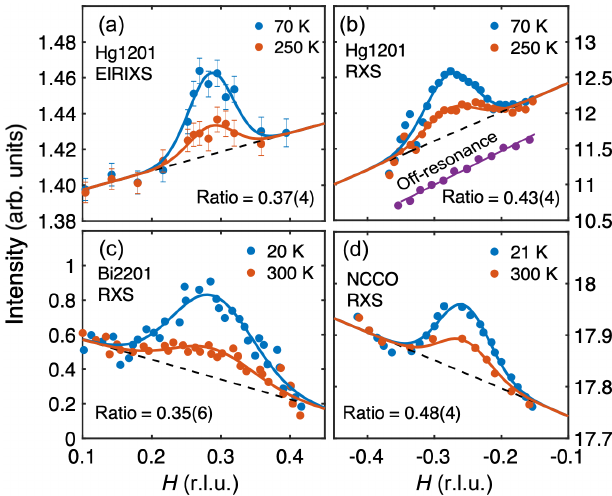
FIG. 5. (a) Energy-integrated RIXS (EIRIXS) data for Hg1201, integrated over the entire experimental energy range ð − 10 ; 2 Þ eV, both at T and 250 K. (b) Prior RXS data for Hg1201 at the same c doping level and temperatures as in (a), along with 70 K data taken off resonance with an incident photon energy of 929 eV, reproduced from Ref. [9]. (c) RXS measurement of Bi 2 Sr 2 − La CuO 6 þ δ (Bi2201, x ¼ 0 . 115 ) at ∼ T and 300 K, x x c reproduced from Ref. [8]. (d) RXS results for superconducting electron-doped Nd 2 − Ce CuO 4 (NCCO, x ¼ 0 . 145 ) at ∼ T and x x c 300 K, reproduced from Ref. [18]. In all cases, the high- temperature data are vertically shifted for comparison with the low-temperature result. Black dashed lines, assumed linear background. Solid lines, fits to Gaussian peak plus assumed linear background. Estimates of relative peak amplitudes are indicated in all